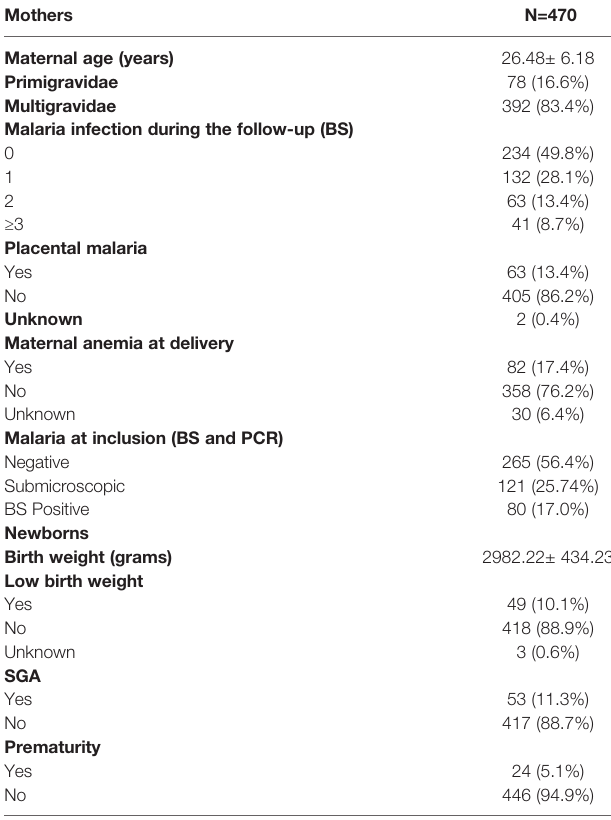
TABLE 1 | Characteristics of the